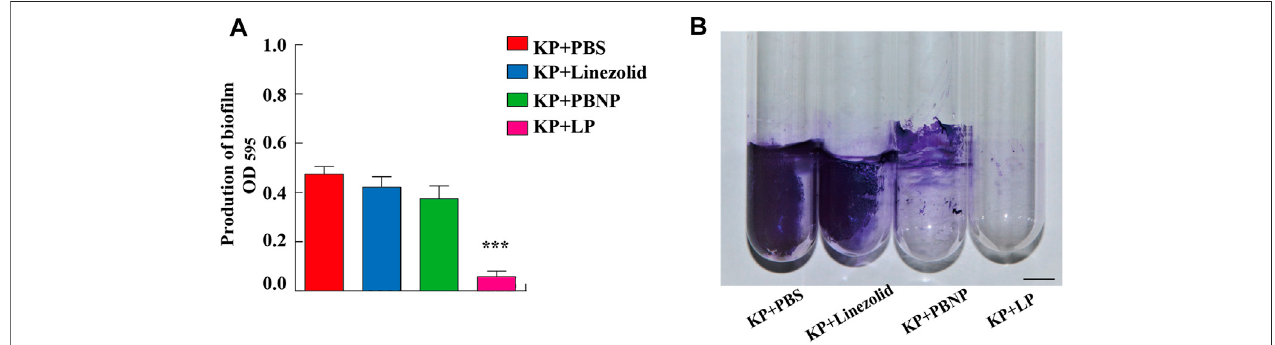
FIGURE2| Thebio fi lmproductionof K.pneumoniae treatedbyLP. (A,B) 1×10 6 CFUofKPWTorwereseededin24-wellplates (A) orglasstubes (B) andtreated with PBS, linezolid (16 μ g/ml), PBNP (8 μ g/ml) or LP for 12 h. The bio fi lm production was detected at OD 595 by microplate reader. Scale bar, 1 cm. Data are shown as the mean ± SEM of three independent experiments. *** p < 0.001.